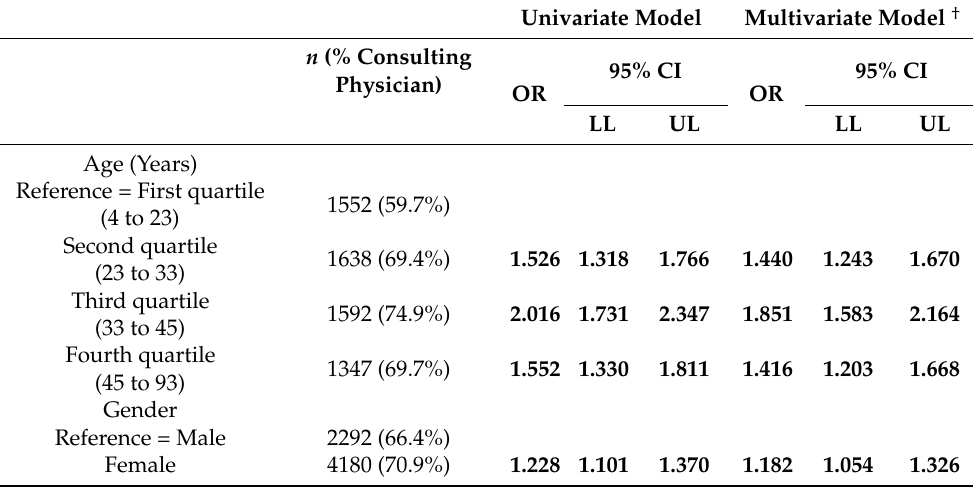
Table 2. Association of physician consultation * with baseline